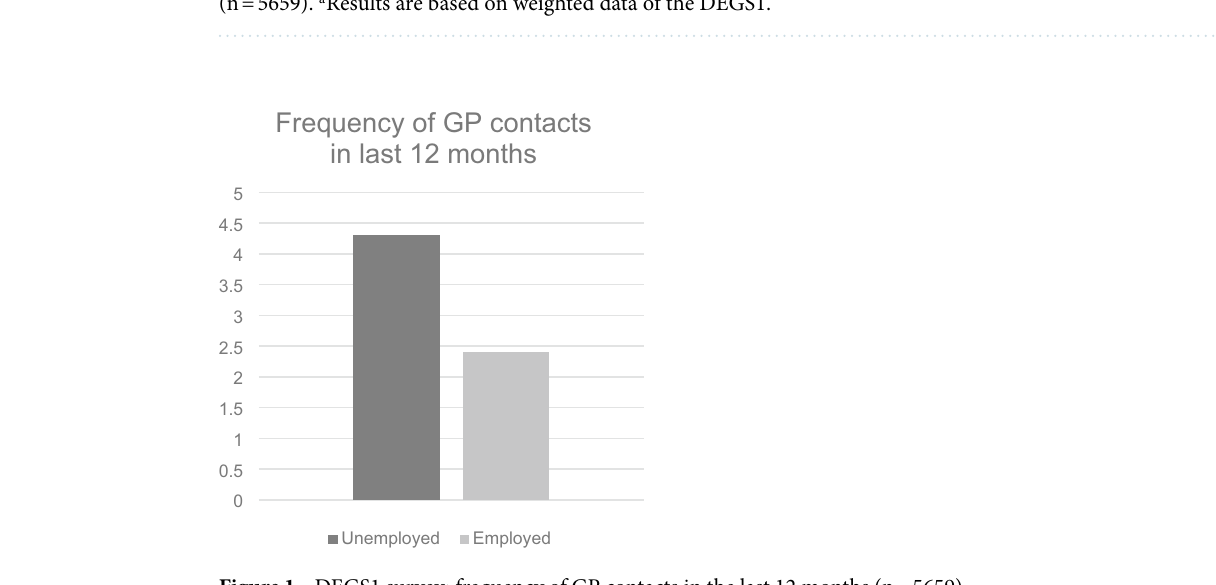
Figure 1. DEGS1 survey: frequency of GP contacts in the last 12 months (n =